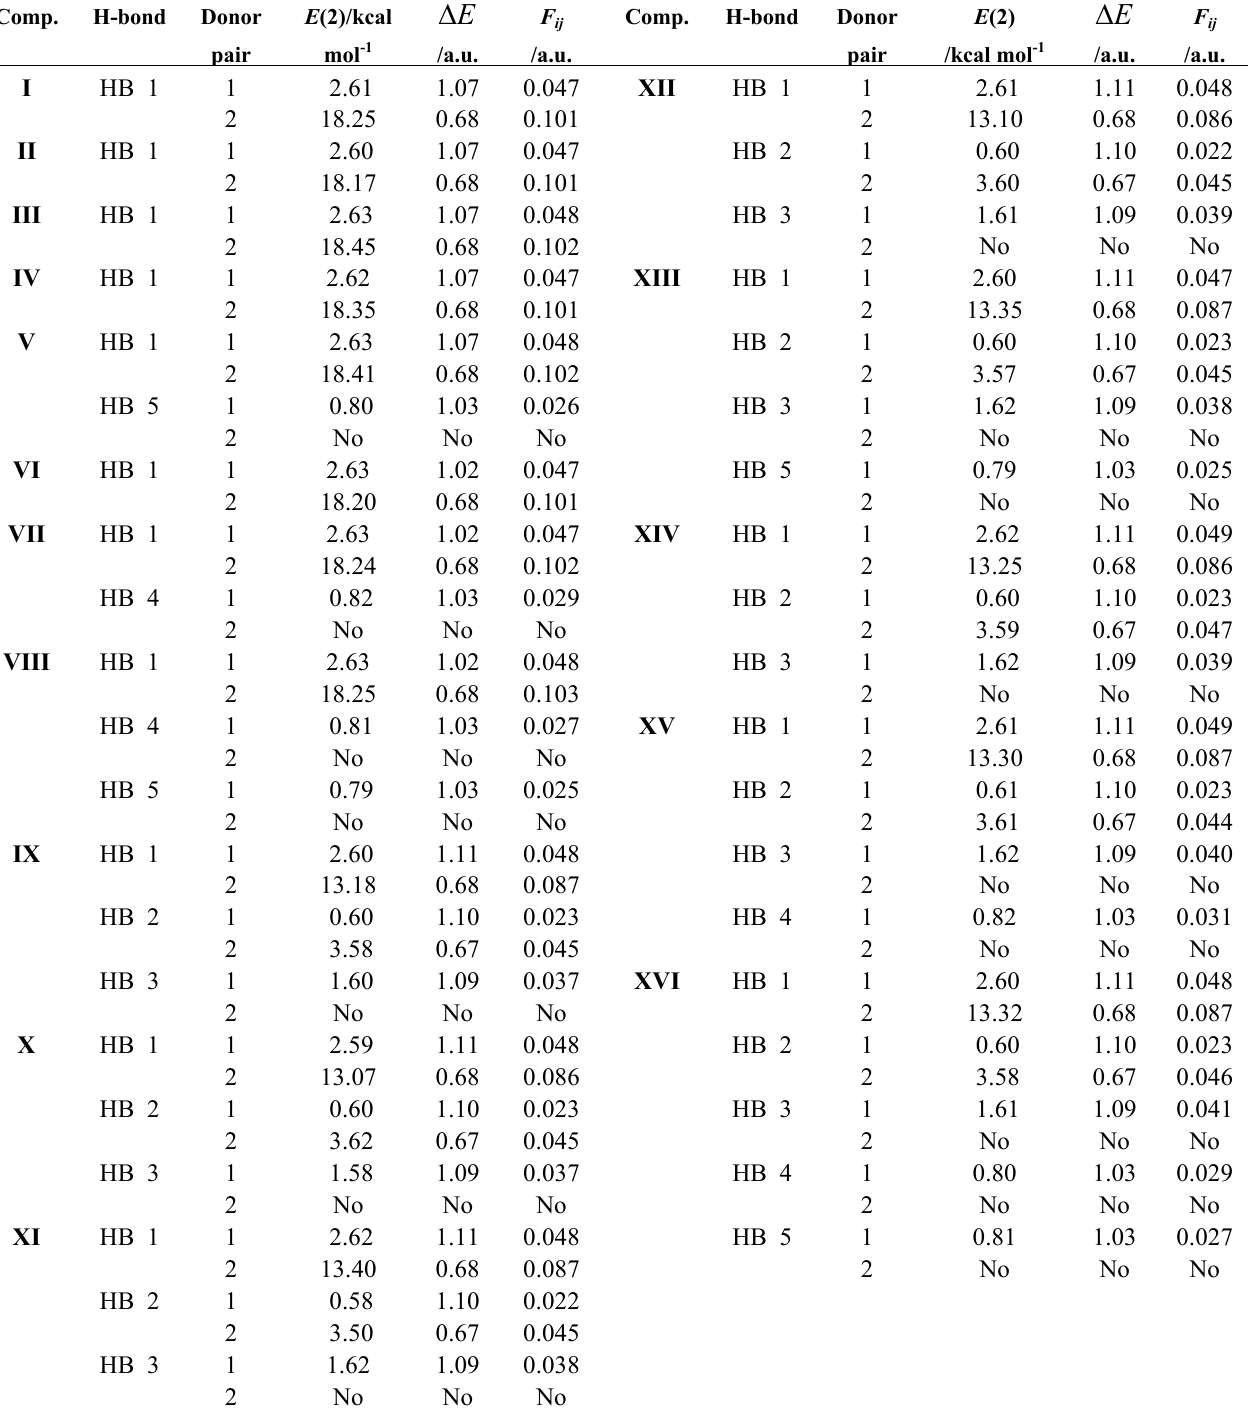
Table 6. NBO analysis of studied flavonoids monomers computed in gas phase at the B3LYP/6-311++G** theoretical level. Second order perturbation energy, E (2); energy difference among the donor and the acceptor, E  ; and Fock matrix element between